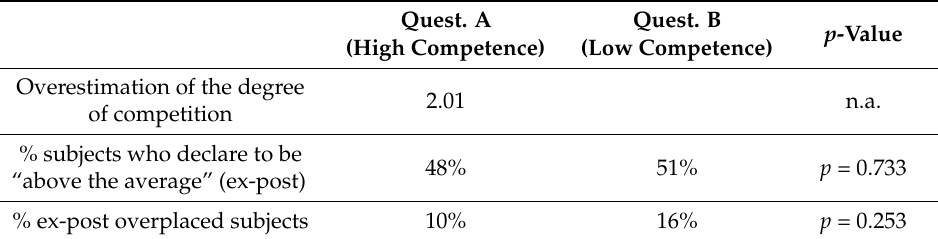
Table 2. The placement and perceived competence in the Self Selection treatment (averages).